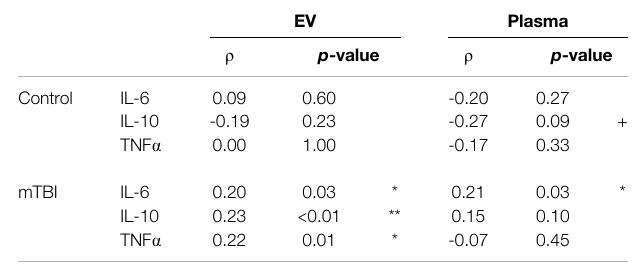
TABLE 2 | Spearman ’ s correlations for the relationship between PSQI and in fl ammatory cytokine concentrations in control and mTBI cohorts. +